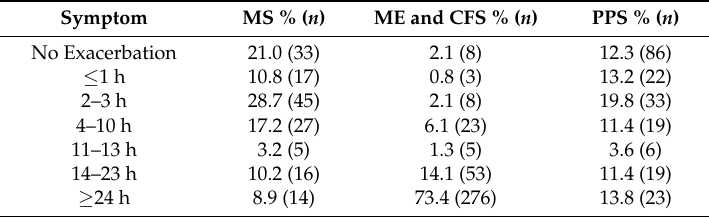
Table 3. PEM duration reported by patient